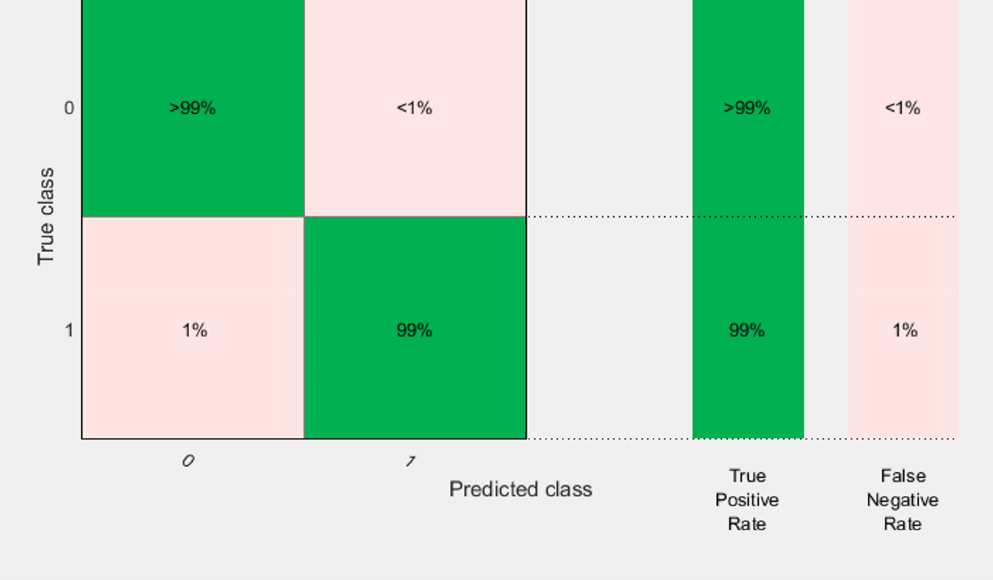
Figure 19. Confusion matrix of accelerometer (ACC) and EMG measured from forearm muscle bagged tree classifier.